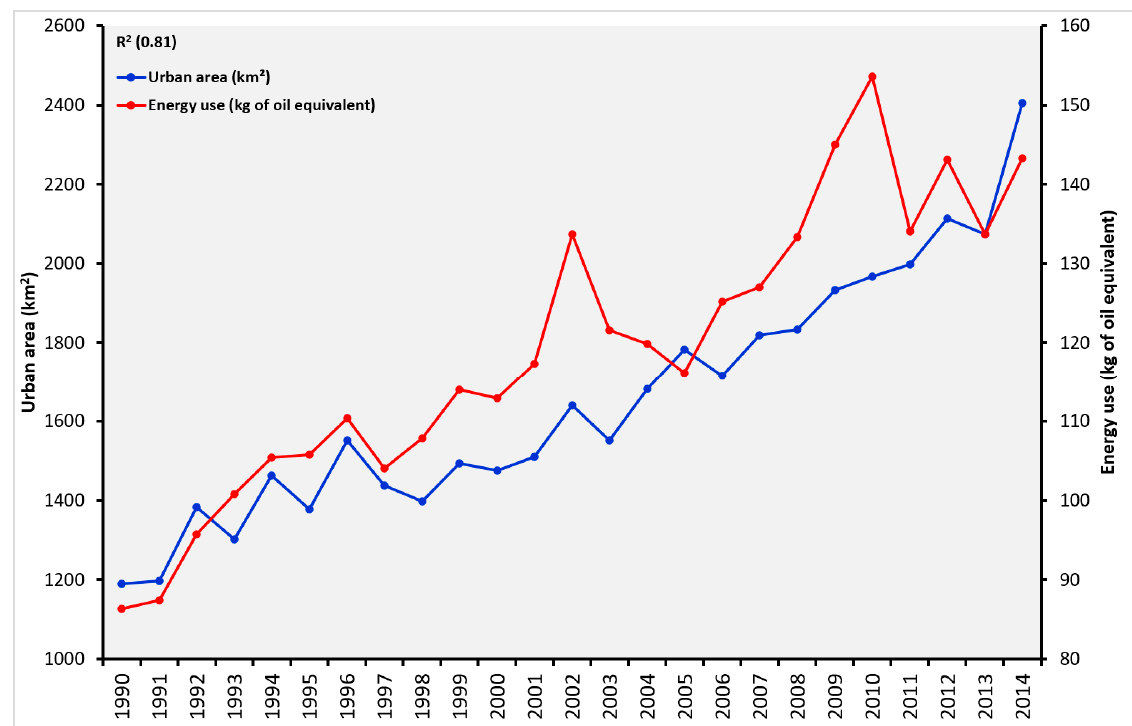
Figure 15. The urban area of the capitals and the energy use of the country.